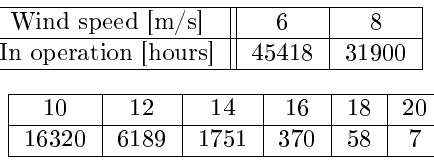
Table 1: Hours of operation at di(cid:27)erent wind speeds (binned). Total operation is 102013 hours.